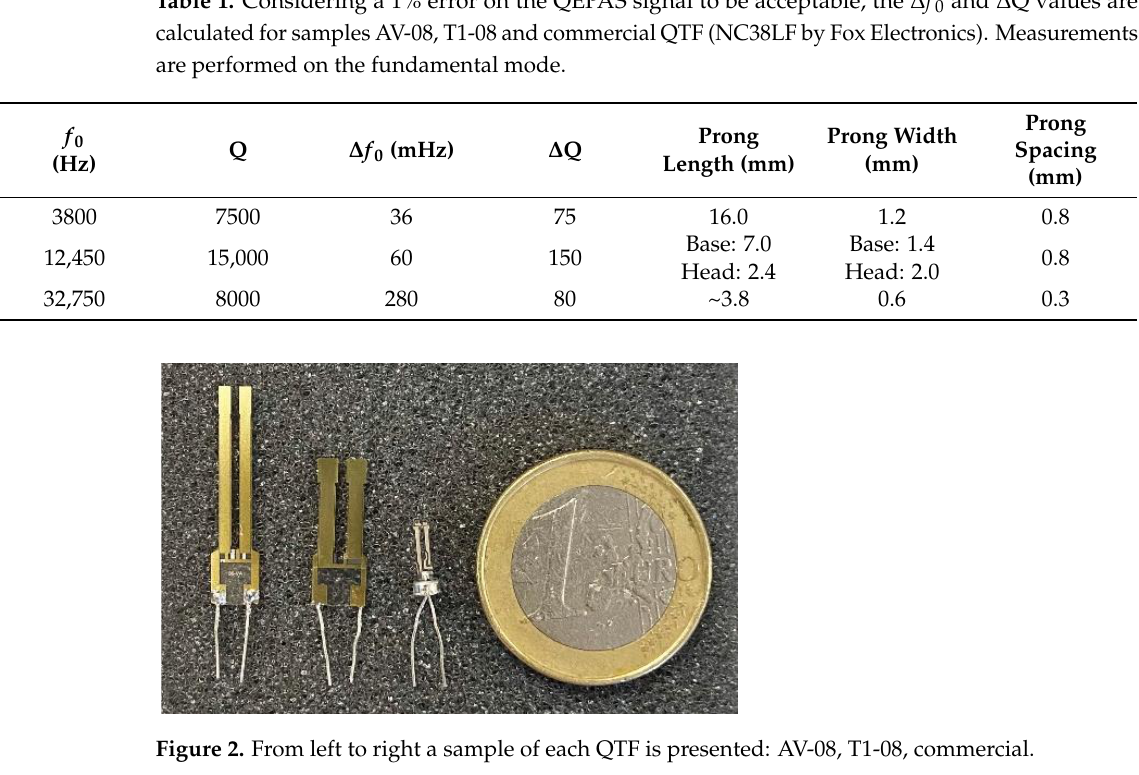
(green) and Q-factor reduction of 80 (blue). The two curves intersect (red dot) at f = f 0 , corresponding to a 1% QEPAS signal error as calculated.